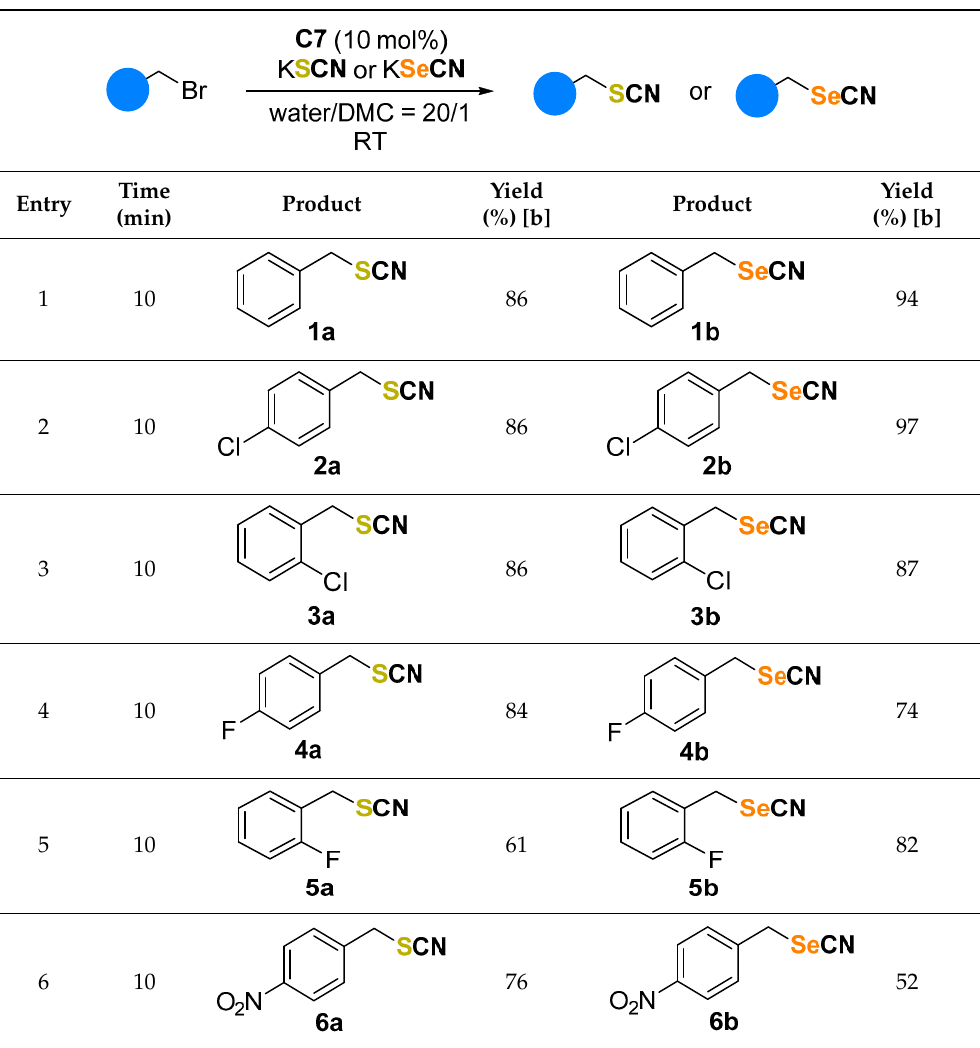
Table 3. Substrate scope for the preparation of thio- and selenocyanates catalyzed by C7 . [a].